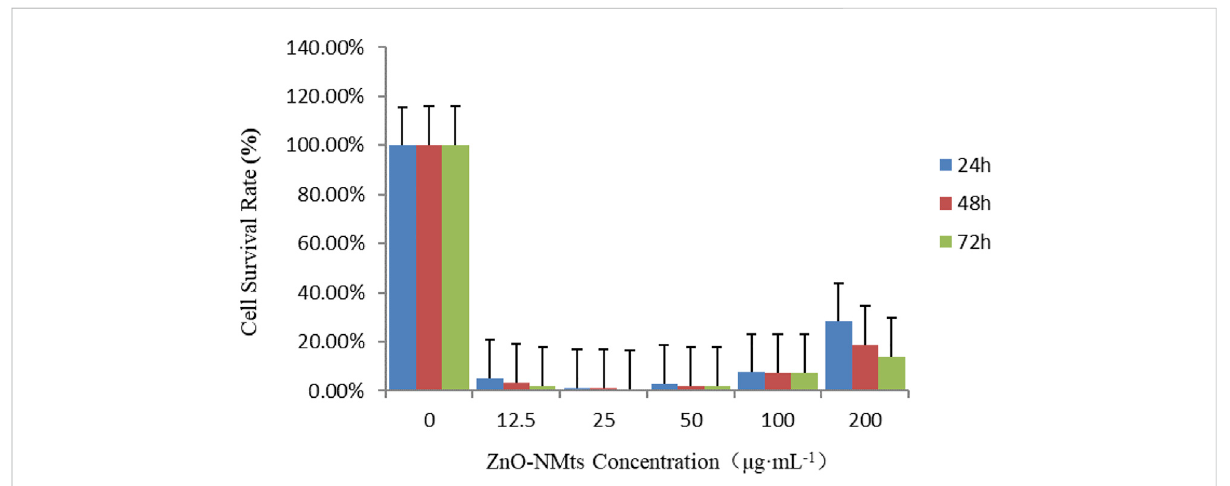
FIGURE 4 ViabilityofEBLcellstreatedwithZnOnanomaterialsfor24,48,and72 h.Asshowninthe fi gure,thesurvivalrateofEBLcellsdecreasedwiththe increase in the action time of ZnO